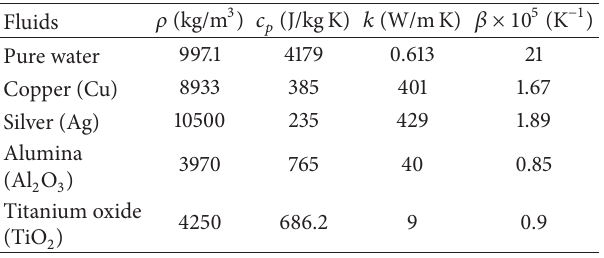
Table 1: Thermophysical properties of water and nanoparticles [21]. Fluids